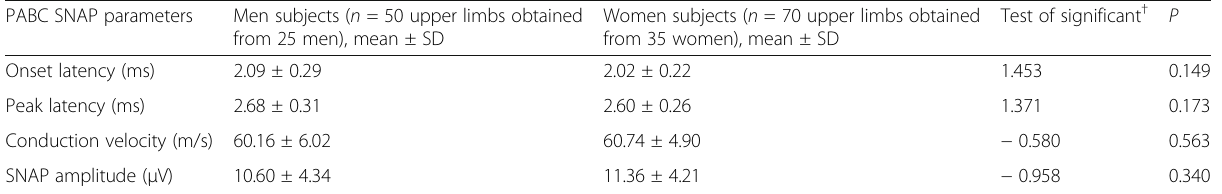
Table 2 Comparison between men and women regarding different posterior antebrachial cutaneous sensory nerve action potential parameters PABC SNAP parameters Men subjects ( n = 50 upper limbs obtained Women subjects ( n = 70 upper limbs obtained Test of significant † from 25 men), mean ± SD from 35 women), mean ± SD